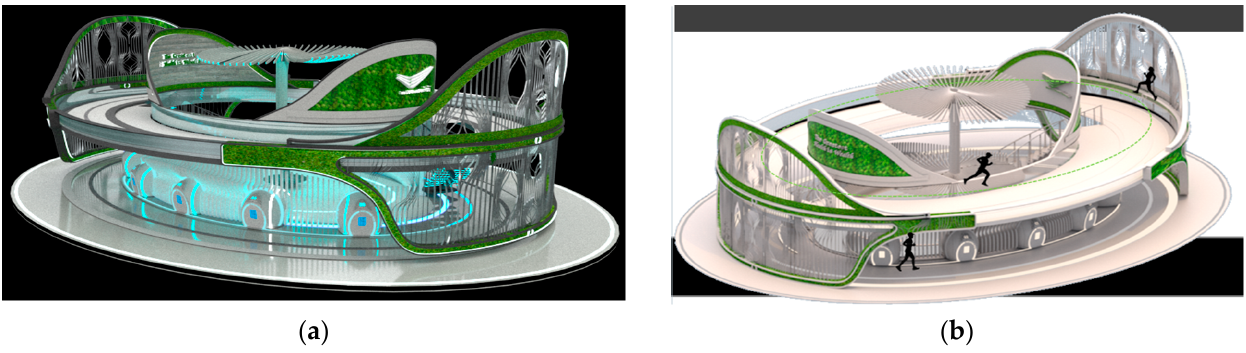
Figure 16. ( a ) 3D perspective; ( b ) 3D perspective showing the double floor walking track (designed by the authors).